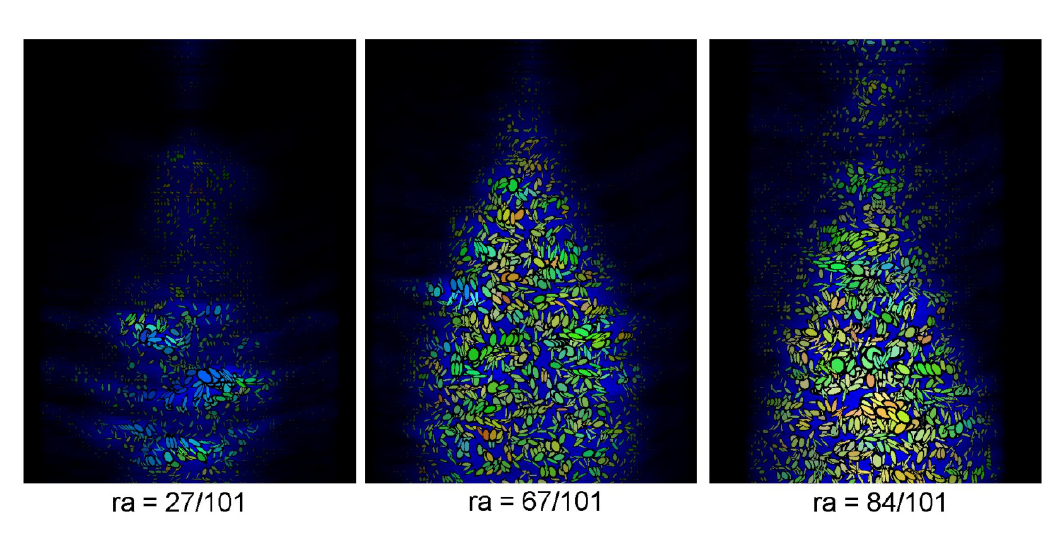
Figure 6. Azimuthal slices through a three-dimensional dataset of a fir tree, taken from a time series animation. When viewed in series, the ellipses show the scattering properties of individual